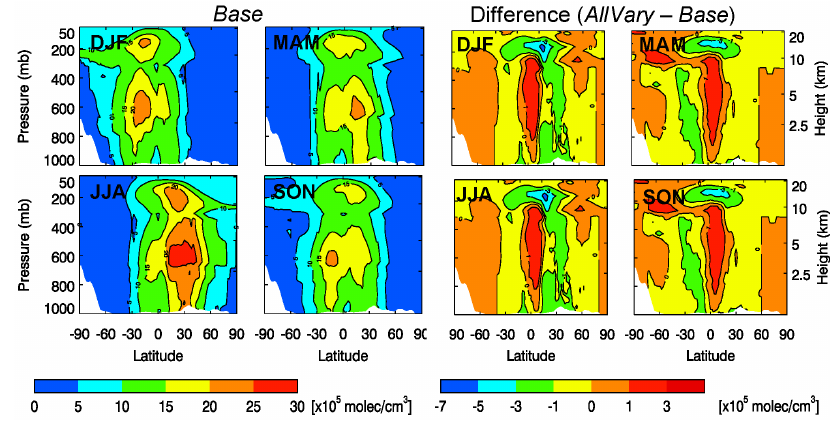
Figure 2. Seasonal zonal mean (1988–2007) of OH ( × 10 5 moleculescm − 3 ) for the Base scenario (left four panels) and the difference ( AllVary – Base , right four panels) for December–February (DJF), March–May (MAM), June–August (JJA), and September–November